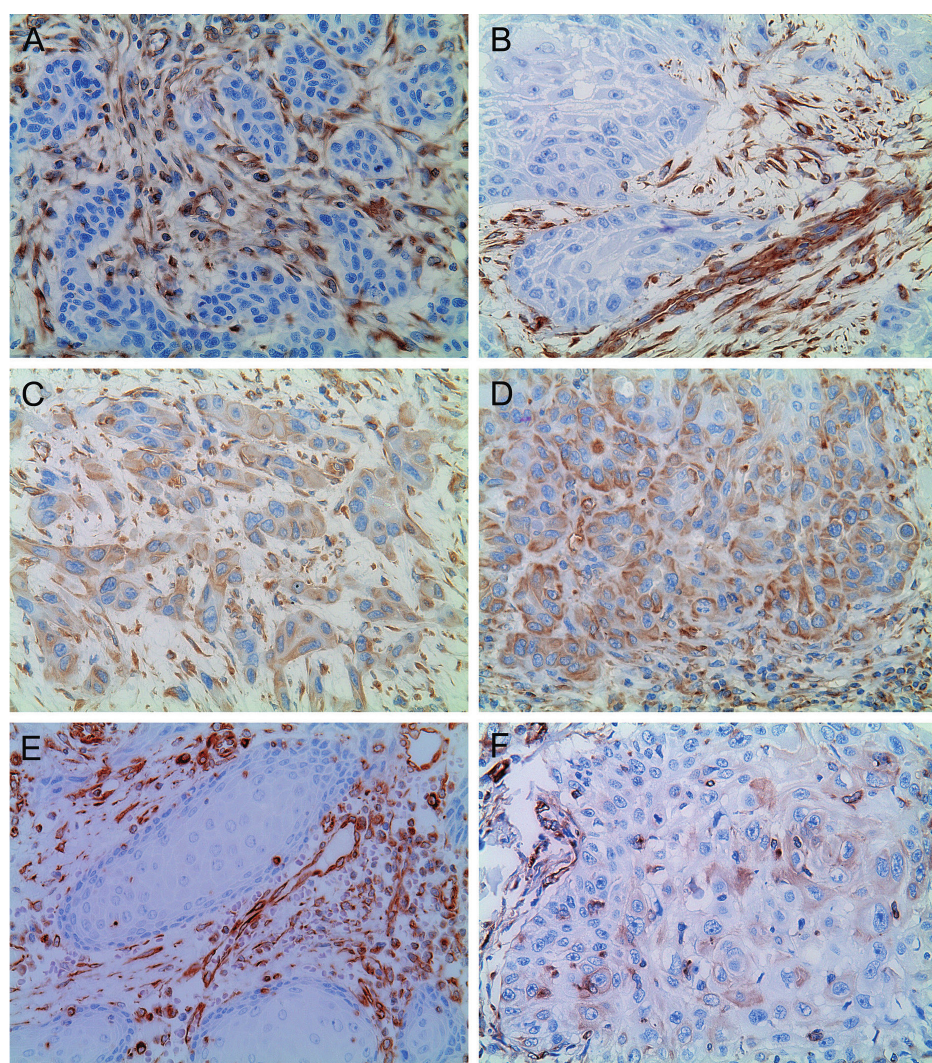
Figure 3- Immunohistochemical reactivity for vimentin in oral squamous cell carcinoma (OSCC). Immunostaining of the tumor’s connective tissue mesenchymal cells was used as an internal positive control. A and B: OSCC showing negative vimentin expression (A, X400; B, X400); C and D: OSCC displaying positive vimentin expression at the IF (E, X400; F, X400); E: OSCC exhibiting negative vimentin expression at the CSA (E, X400). This is the same sample of the Figure 1A (preserved E-cadherin expression); F: OSCC displaying positive vimentin expression at the IF (E, X400). This is the same sample of the Figure 1D (reduced E-cadherin